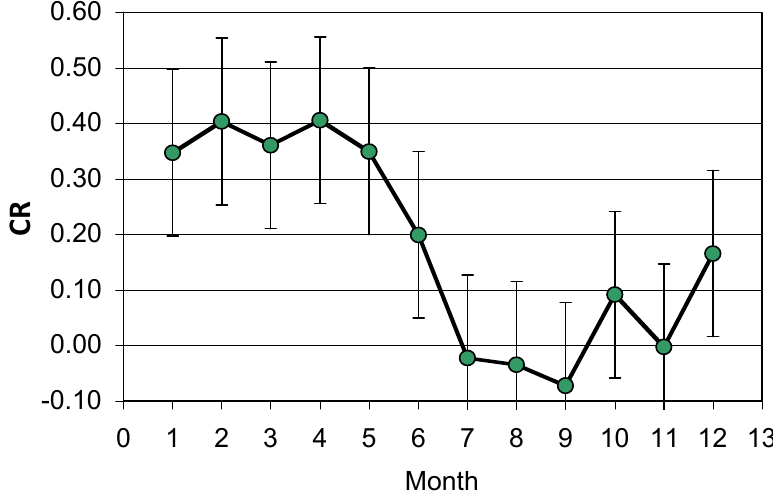
Figure 13. Concentration reductions (CR) over the course of the year for the four Apopka steady flow large P wetlands. Error bars are the average standard deviation for all months.